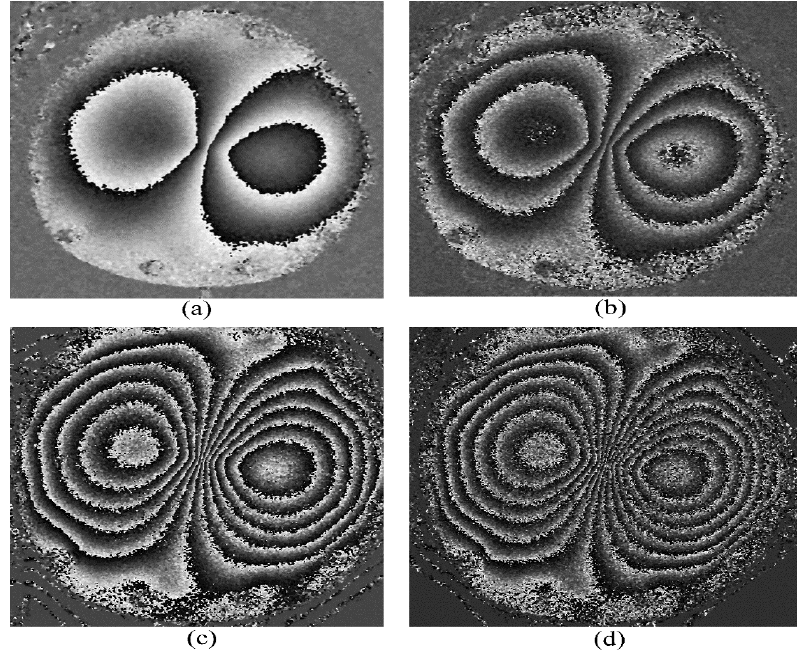
Figure 6. Phase map generated by the 4 + 1 phase stepping algorithm for applied central deformations of ( a ) 10 µ m, ( b ) 25 µ m, ( c ) 45 µ m, and ( d ) 55 µ m from the Nikon D5300 camera.